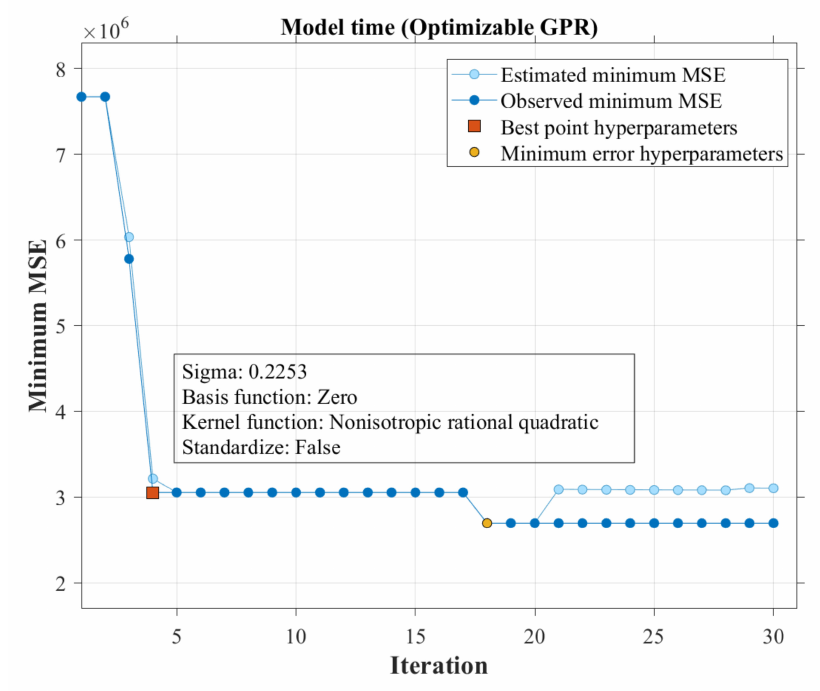
Figure 5. Bayesian optimization